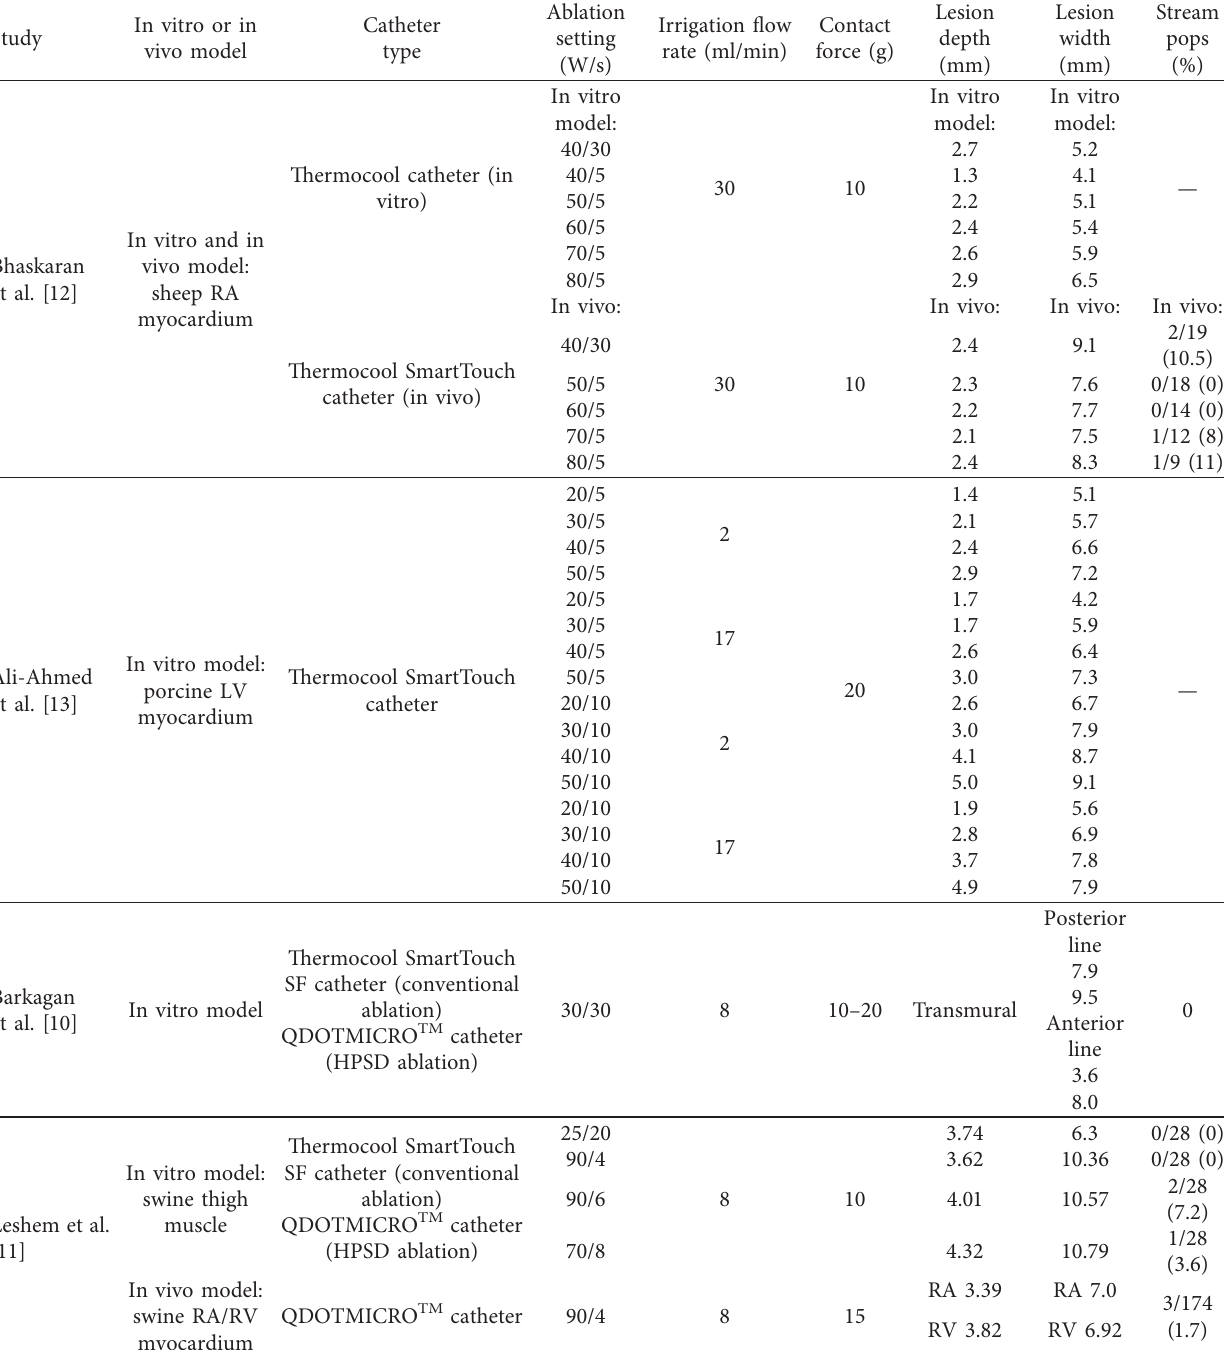
Table 1: In vitro and in vivo studies on HPSD